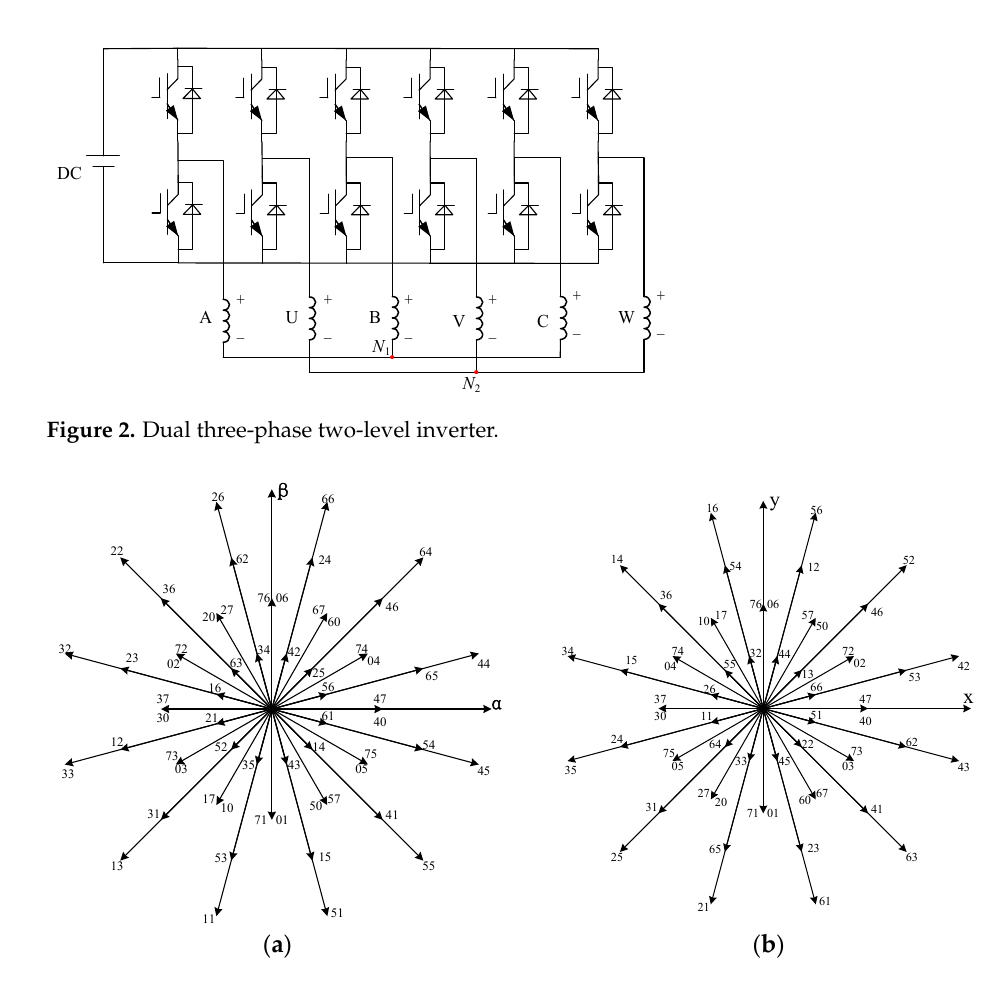
Figure 3. Voltage vectors distributions on different subplaces: ( a ) αβ subplace; ( b ) x-y subplace. It can be seen from Figure 3 that there are 60 non-zero and 4 zero voltage vectors ( V 00 , V 07 , V 70 and V 77 ) in each subplace. The non-zero voltage vectors can be divided into four categories: 12 large vectors (outermost layer), 12 middle vectors (second outer layer), 12 small vectors (innermost layer), and 24 vectors between the second layer and the innermost layer. The specific amplitudes of these four types of vectors are listed in Table 1. Table 1. Four types of voltage vectors.